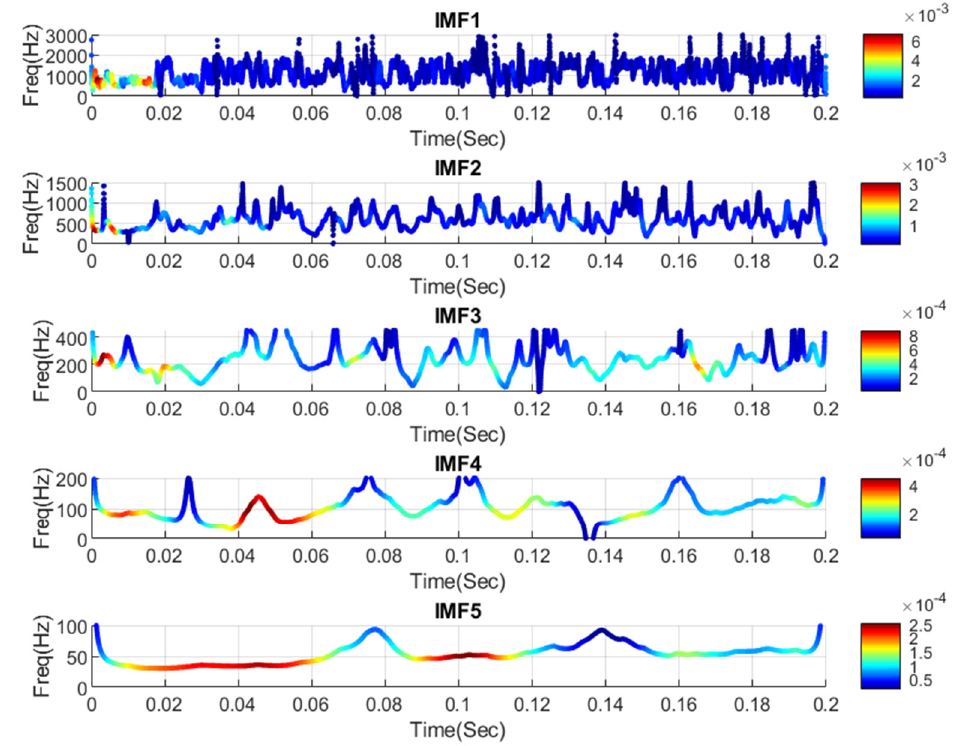
Figure 16. Instantaneous frequencies of dominant IMFs for A90C1 Serviceable Pole 1 using improved HHT.